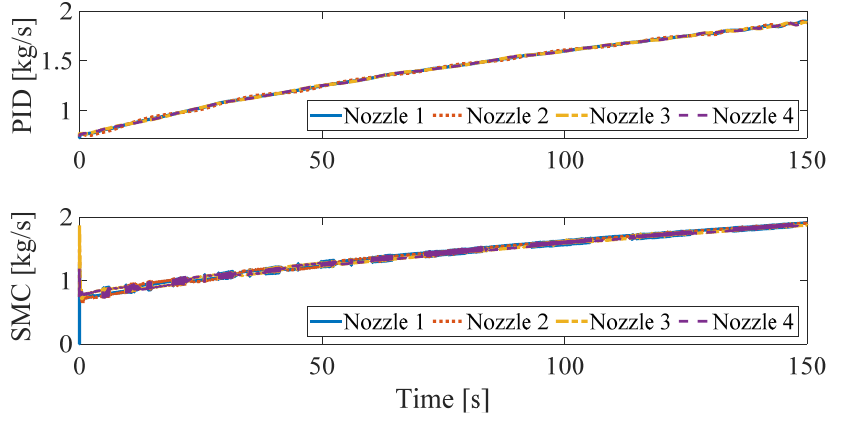
Figure 12. The mass flow rate of each nozzle.